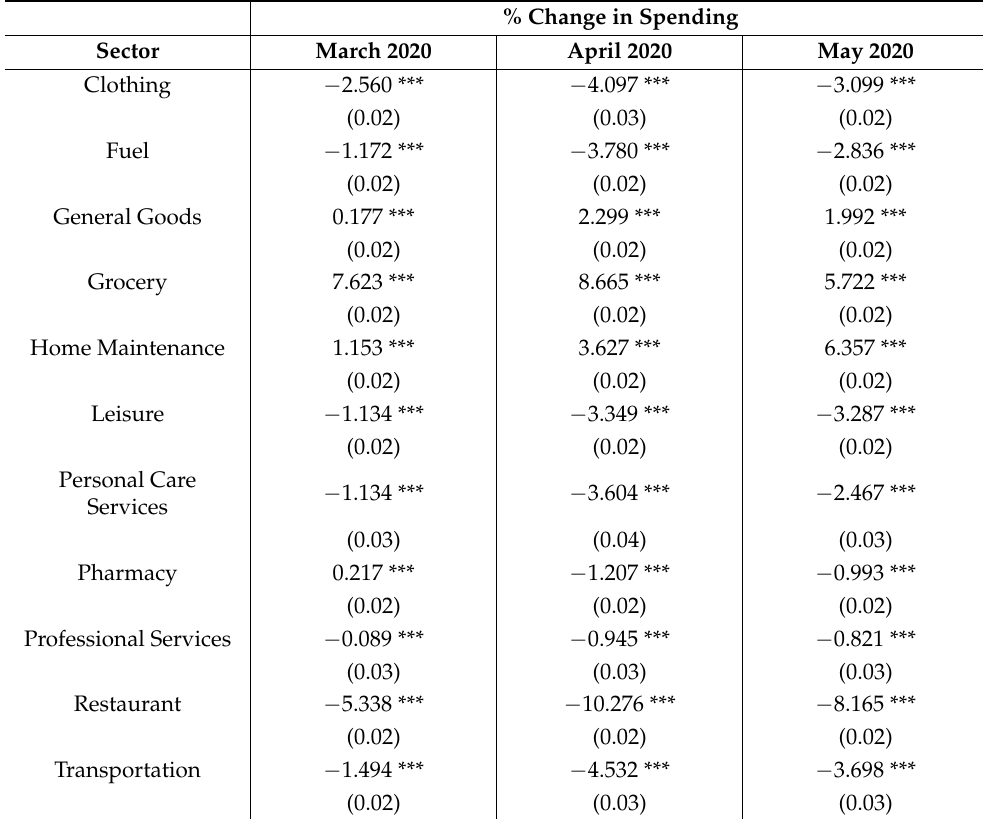
Table 2. Estimated Changes in Expenditure Share across